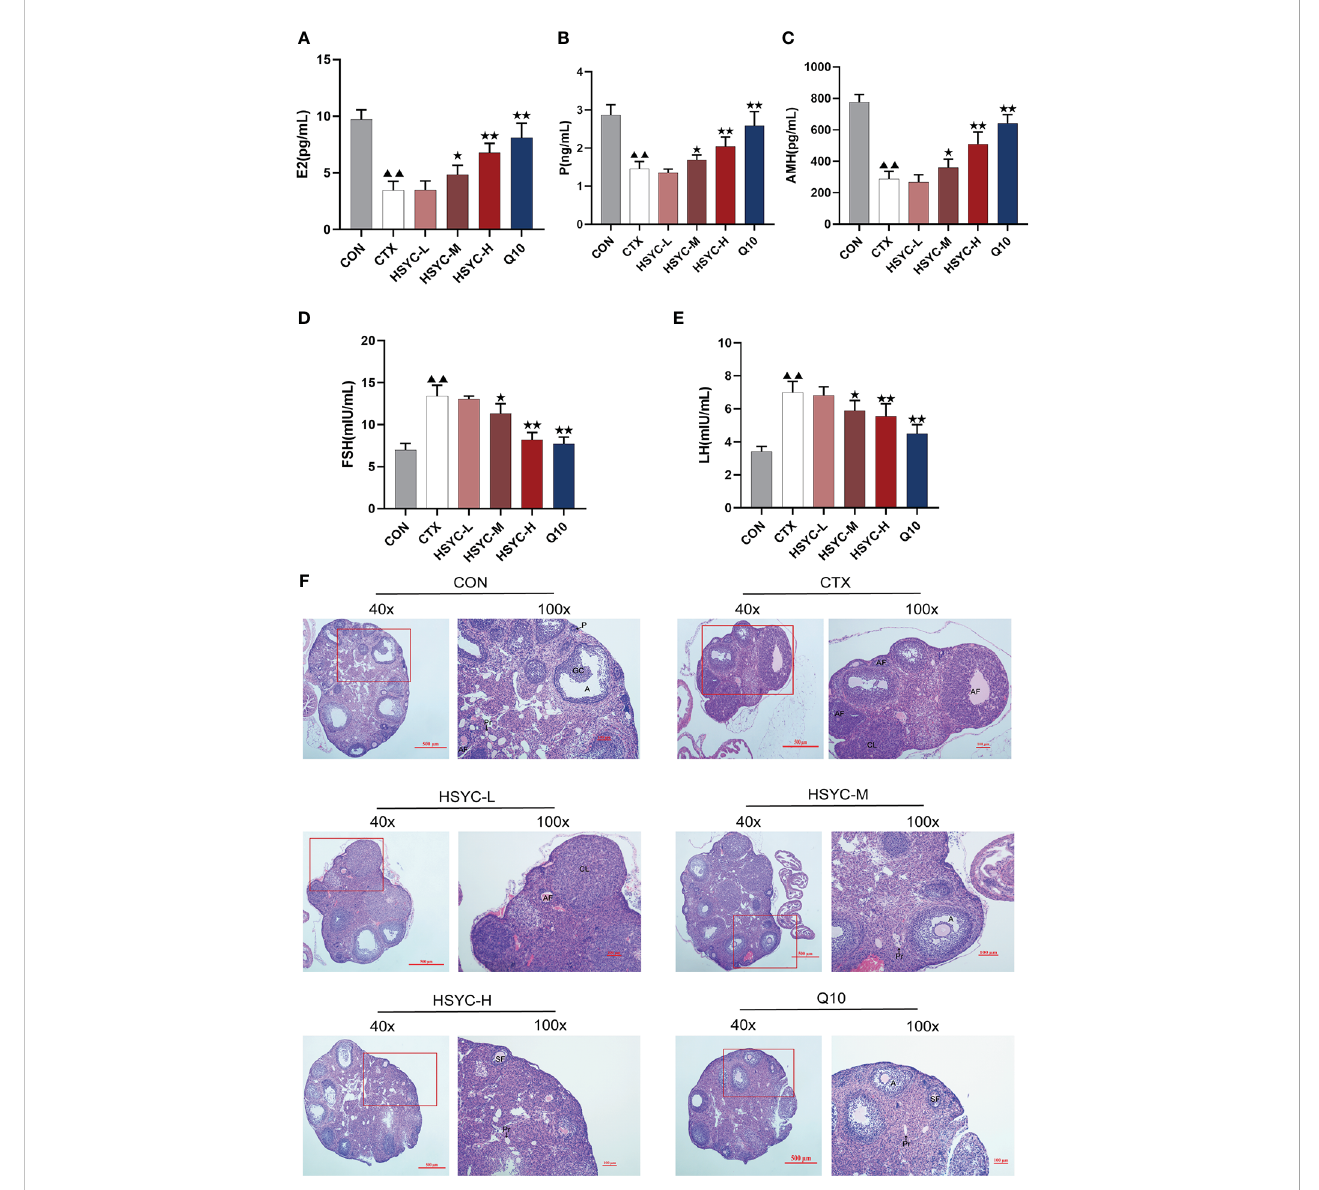
FIGURE 2 HSYC improved ovarian function in POI af fl icted mice. (A-E) The level of serum estrogen, progesterone, anti-Müllerian hormone, follicle stimulating hormone and luteinizing hormone of mice in different groups. (F) Ovarian tissue sections with H&E staining in different groups. Histogram elements represent the mean ± SD (n=6). ▲▲ presents P<0.01 compared to the CON group; ★ presents P < 0.05 compared to the CTX group; ★★ presents P < 0.01 compared to the CTX group. E2, estradiol; P, progesterone; AMH, anti-Müllerian hormone; FSH, follicle stimulating hormone; LH, luteinizing